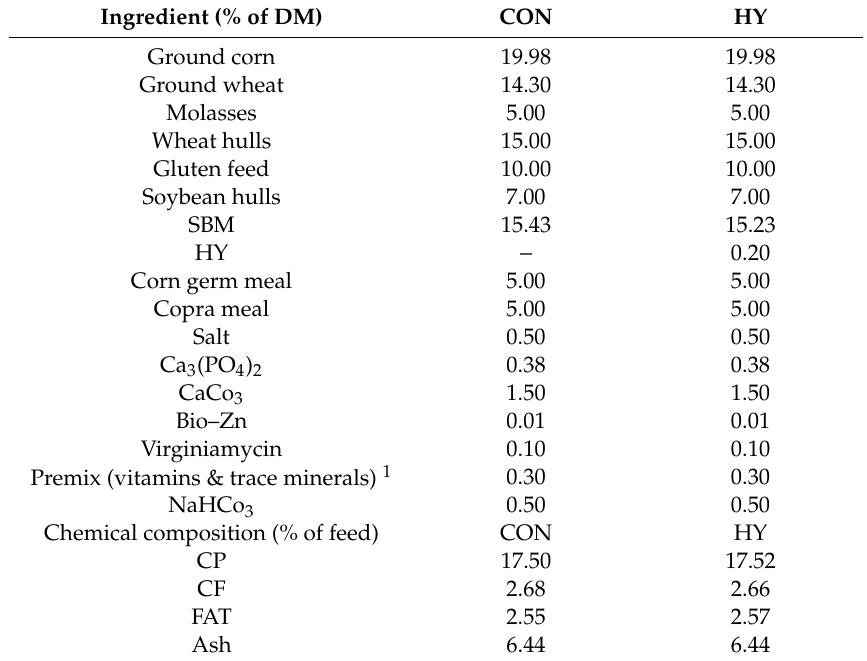
Table 1. Ingredients and nutrient composition (%) of the control and hydrolyzed yeast (HY) calf starters. Ingredient (% of DM) CON HY Ground corn